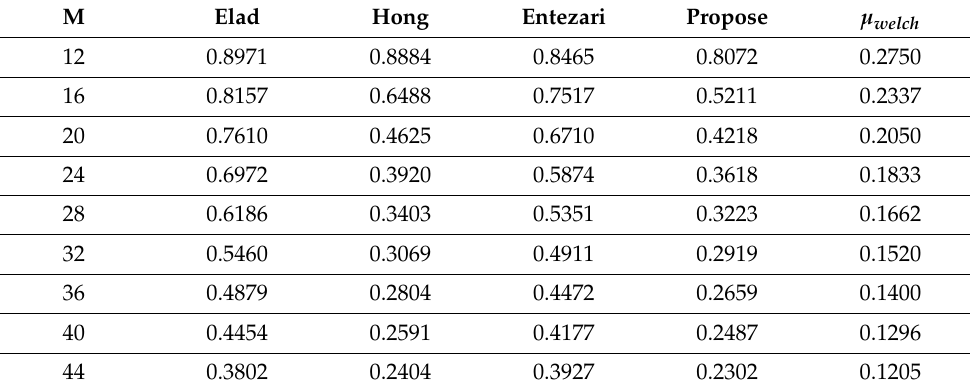
Figure 3. Histogram of the absolute off-diagonal values of Table 1. µ max by Elad, Hong, Entezari, and proposed method versus measurement dimension M .